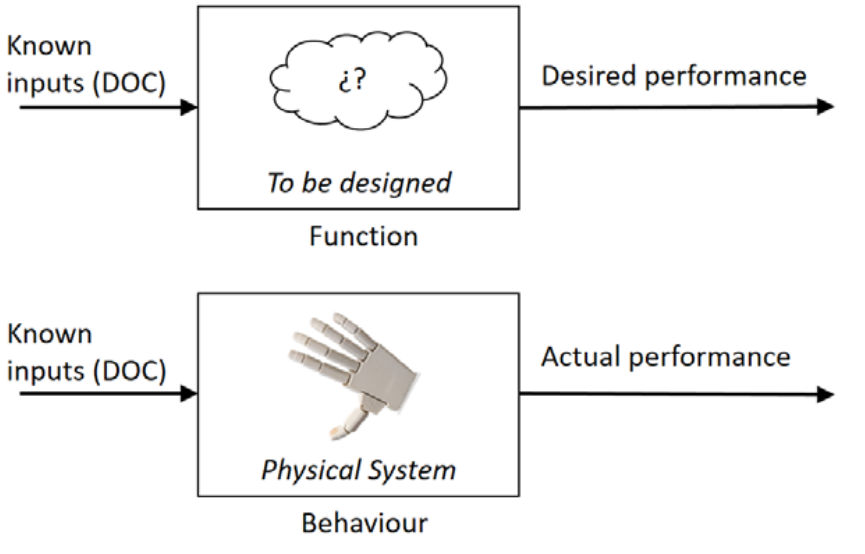
Figure 3. Function and behaviour.